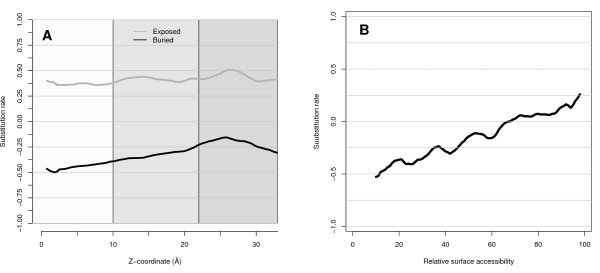
Relative substitution rate and solvent accessibility. A) The relative substitution rate as a function of Z-coordinate. Evolutionarily conserved sites have low values and variable sites have high independently on their distance from the membrane center. Sites that are solvent accessible and inaccessible are colored differently. B) The relative substitution rate as a function of relative accessibility for all residues show a linear relationship.